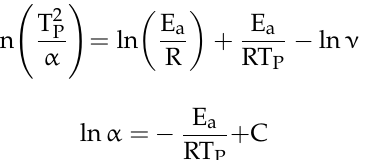
Table 4. Phase transition activation energies of specimens from different silicon